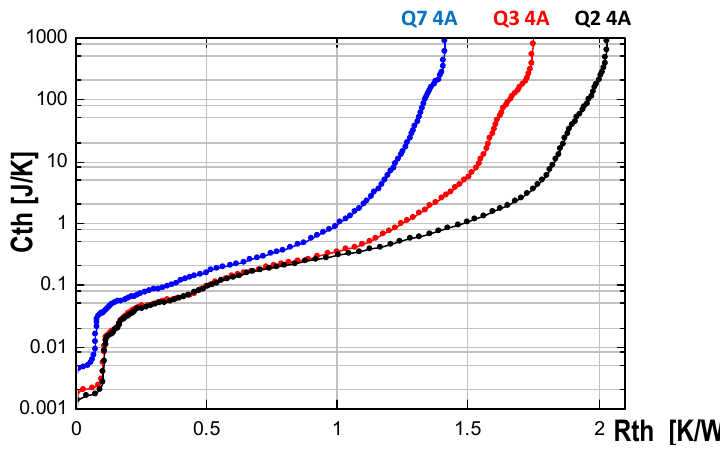
Figure 29. Structure functions: paths from Q2, Q3, and Q7 to the ambient temperature.